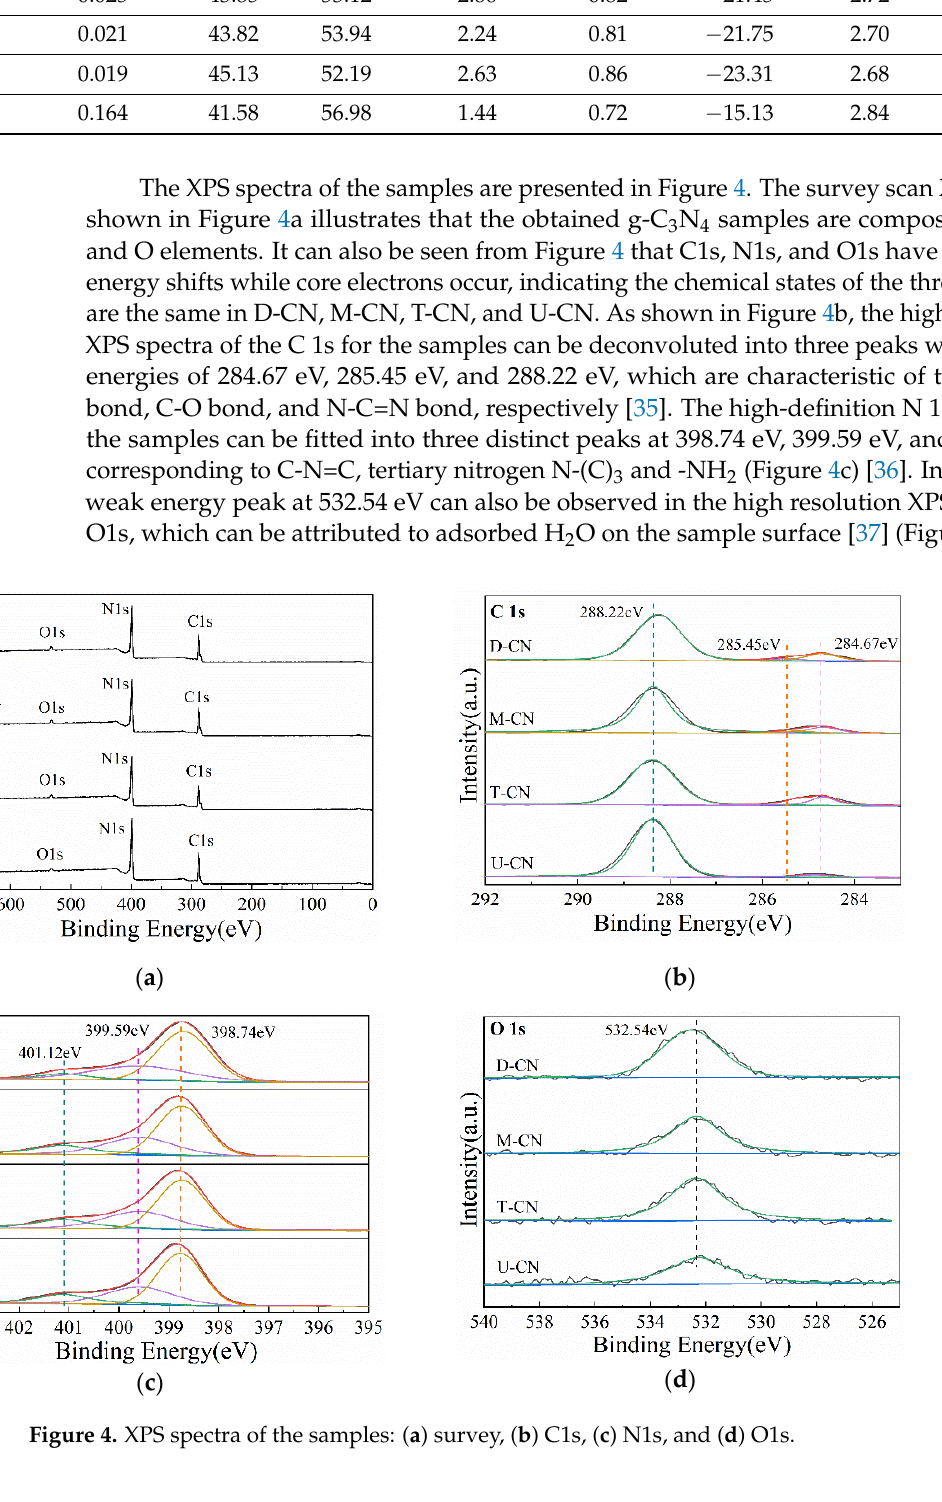
Figure 3. ( a ) N 2 adsorption-desorption isotherms and ( b ) corresponding pore size distribution curves of D-CN, M-CN, T- CN, U-CN.